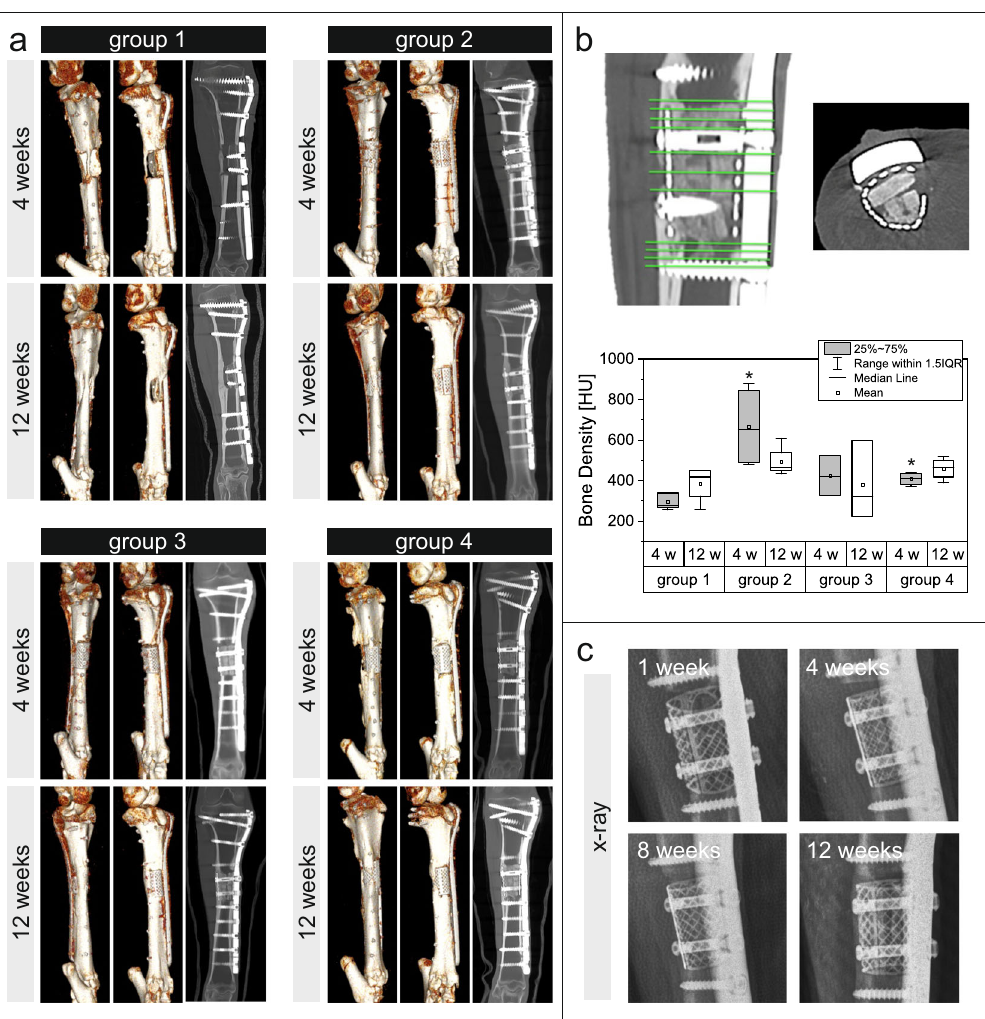
Fig. 2 3D imaging and X-ray of bone defects. a Pictures show the 3D reconstruction of CT analyses of the complete tibia as volume reconstruction and coronal sections 4 and 12 weeks after implantation. b Bone density was measured in 11 different planes distributed over the entire area of the defect. In the axial section bone substitute blocks could clearly be observed within the chamber. Box plot: y-axis shows the bone density in Hounds fi eld units, x-axis depicts the experimental groups after 4 weeks (gray) and 12 weeks (white). c Representative X-ray images of one sheep 1, 4, 8, and 12 weeks after implantation. * p < 0.05 compared to control group 1 (Kruskal – Wallis test/Mann – Whitney U